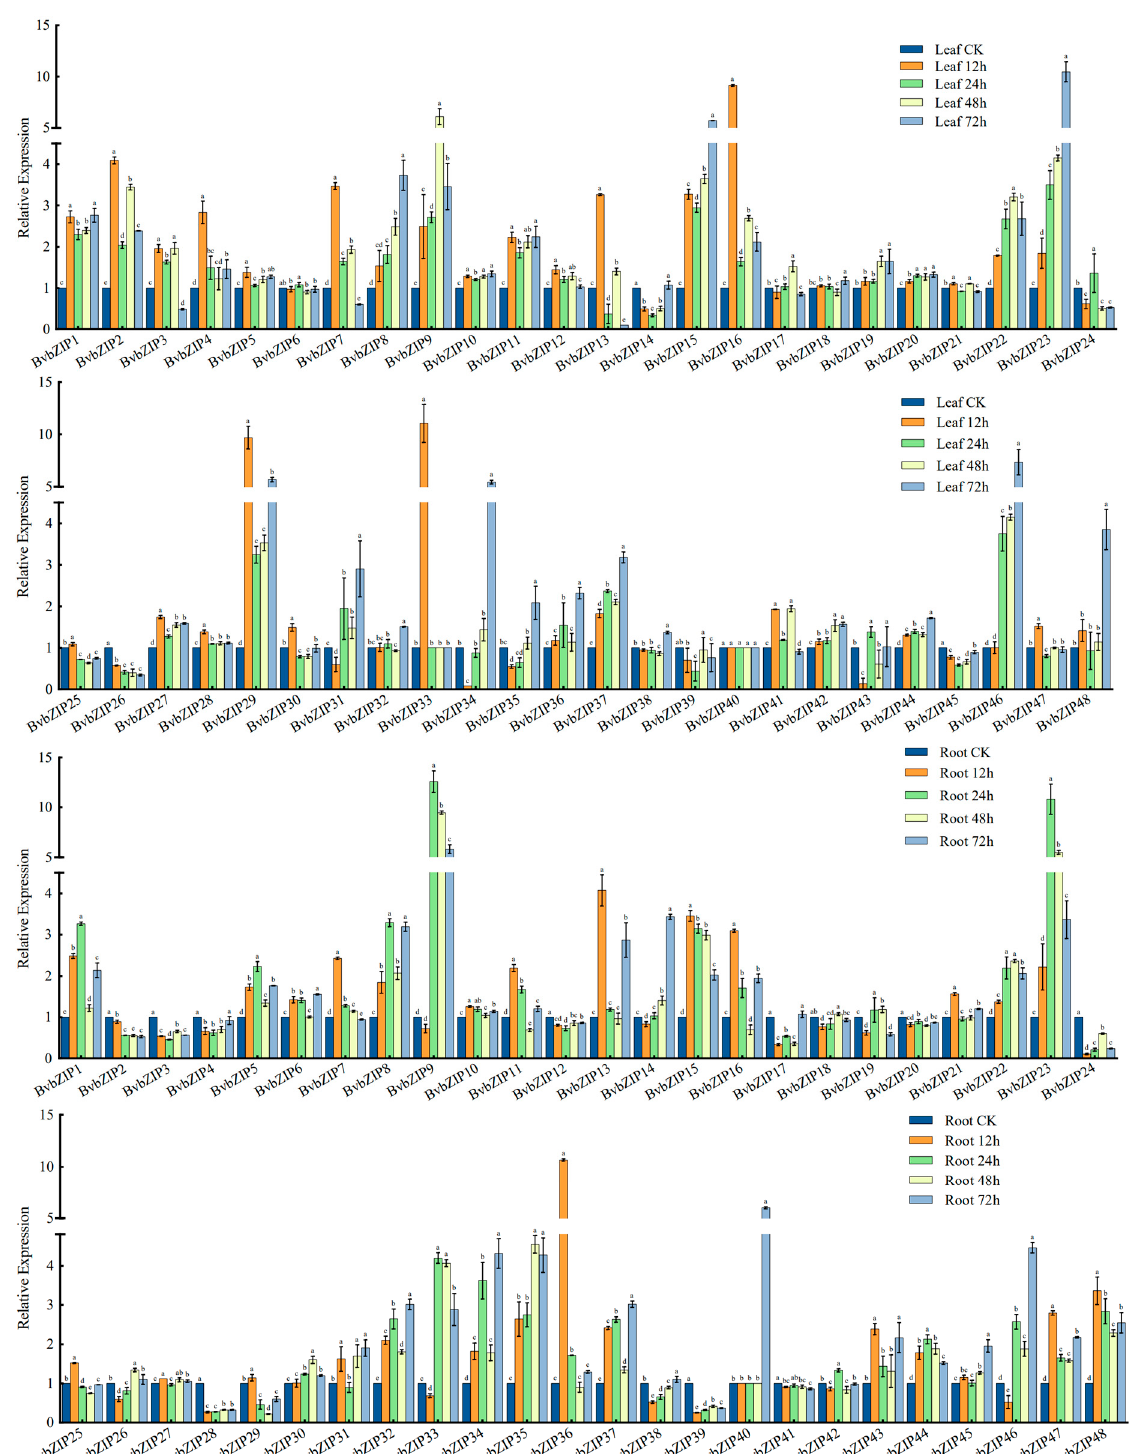
Figure 7. Expression pattern of BvbZIP genes in sugar beet roots and leaves under salt stress. Sugar beet transcriptome data after 300 mM NaCl treatment for 12 h, 24 h, 48 h and 72 h, with 0 h as the control, were obtained from the SRA database. Data were analyzed by Duncan’s analysis of variance, and different lowercase letters indicate differences in